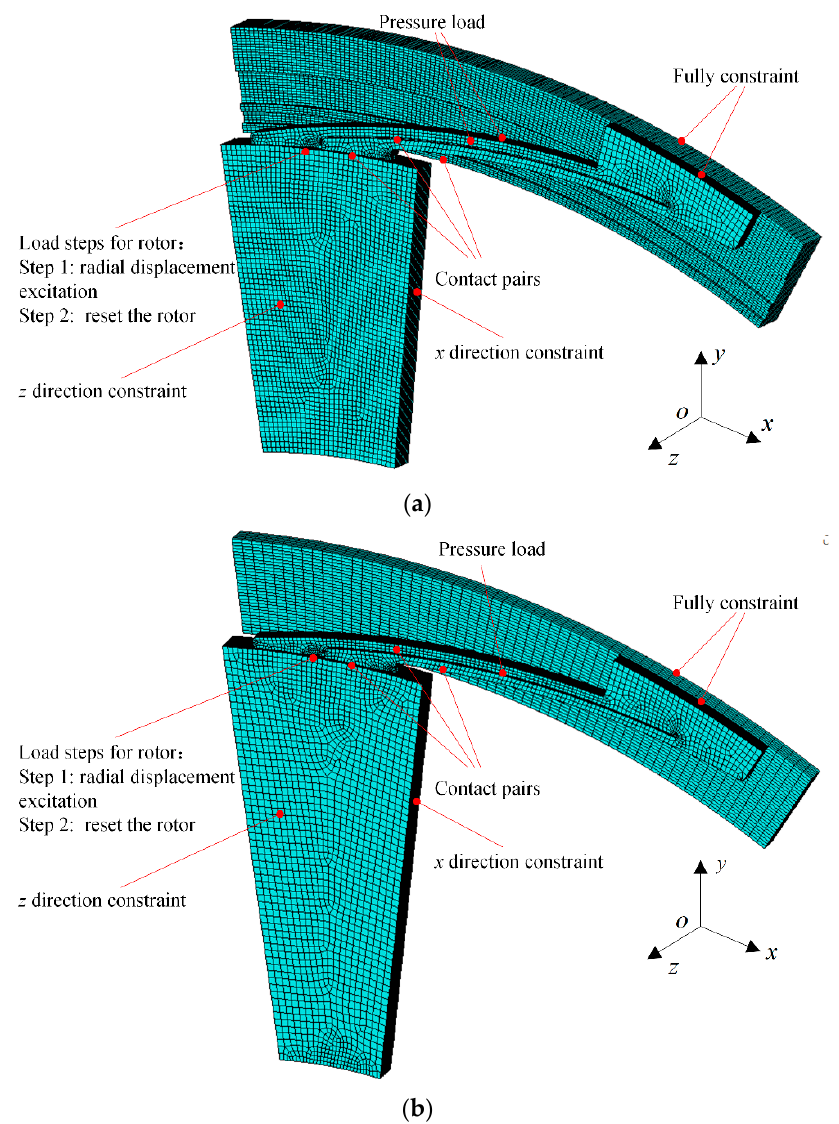
Figure 3. ( a ) Finite element model of the 1st finger seal and ( b ) finite element models of the 2nd finger seal.